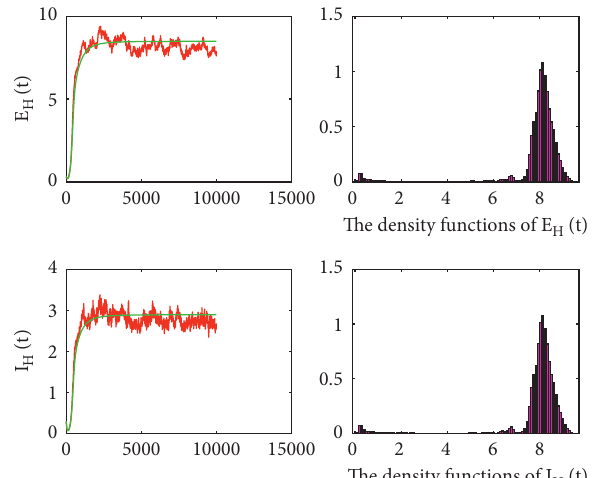
Figure 3: The red lines describe the solution of system (2); the green lines stand for the solution of the corresponding system (1). The right pictures are the histogram of the probability density function for E H , I H